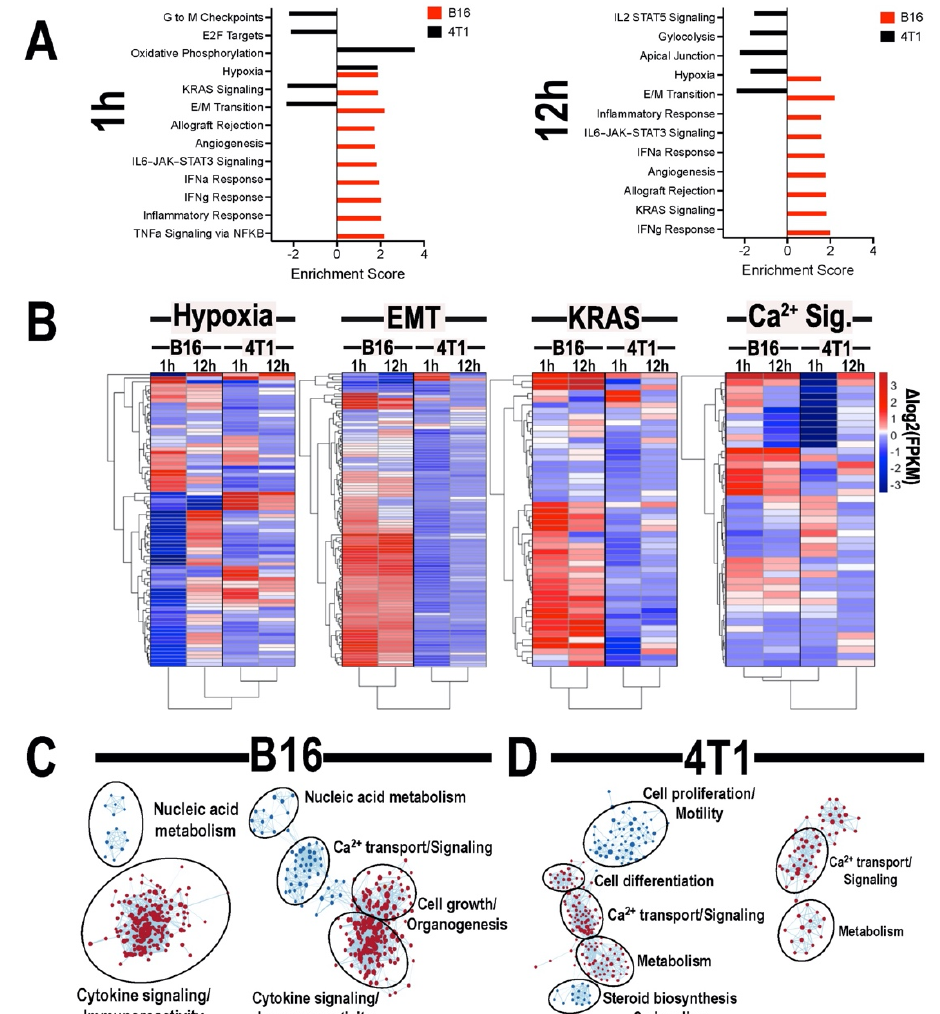
Figure 5. ( A ) Gene ontology (GO) categories of top significantly enrichment obtained from B16 (red bars) and 4T1 (black bars) flank tumors 1 (left) or 12 (right) h following pFUS treatment compared to un-sonicated controls. Log 2 fold change for each gene is shown in its respective bar. ( B ) Hierarchical clustering of gene expression signature associated with hypoxia, KRAS signaling, epithelial to mesenchymal transition (EMT), and Ca 2+ signaling. GO of biological processes gene sets for B16 ( C ) or 4T1 ( D ) tumors 1 (left) or 12 (right) h post-pFUS compared to un-sonicated controls. ( n = 5 mice/tumor type/time point).